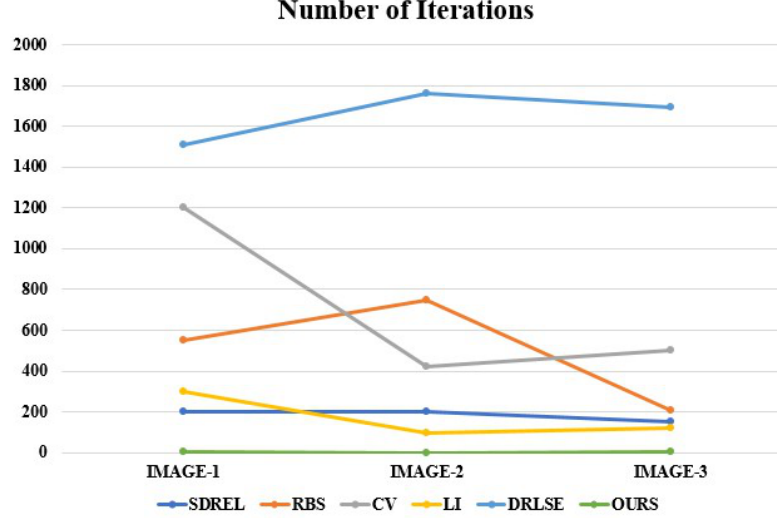
Figure 5. Comparison of our algorithm with five method on the basis of the number of iterations.